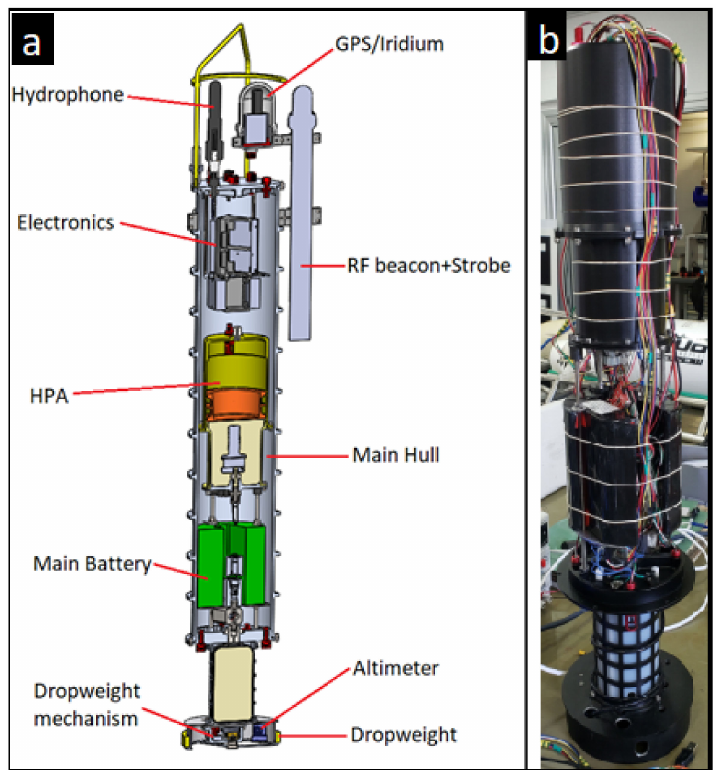
Figure 5. Float general arrangement: ( a ) CAD model (section); ( b ) bottom endcap